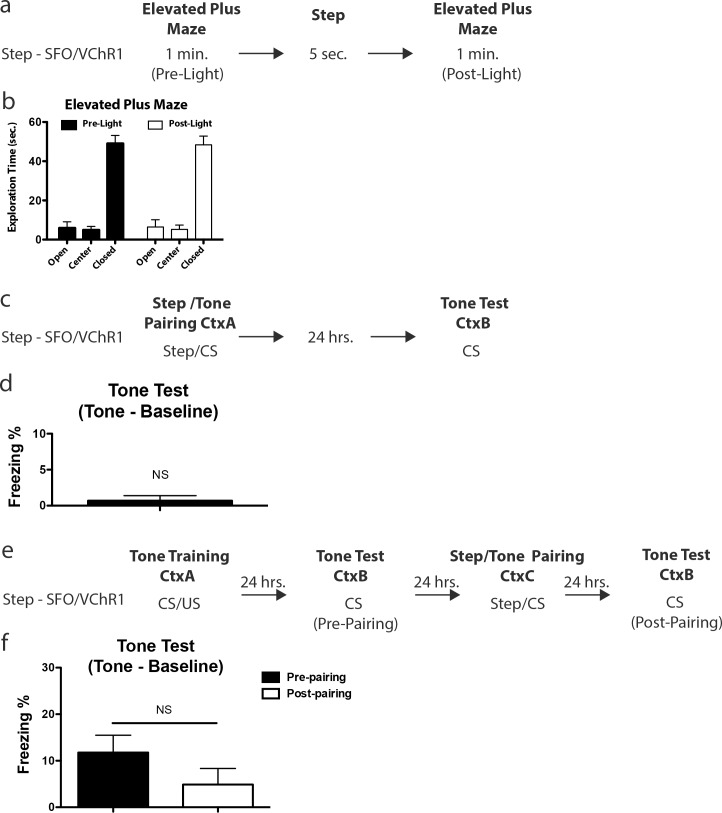
Behavioral controls for excitability induced anxiety and learning.(a) Behavioral design for the elevated plus maze (EPM). (b) The exploration time in the open, center and closed portions of the EPM was monitored for the minute prior to (Pre-Light) and after (Post-Light) a step in excitability. Two-way ANOVA showed a significant effect of arm (F (2,42) = 109.6, p < 0.001) but no significant interaction (F (2,42) = 0.018, p > 0.05) or effect of light (F(1,42) = 3.7x10-7 p > 0.05). The mean exploration times: Pre-Light: Open; 5.96 ± 3.10%, Center; 4.95 ± 1.77%, Closed 49.09 ± 4.06%. Post-Light: Open; 6.43 ± 3.69%, Center; 5.21 ± 2.23%, Closed 48.35 ± 4.46%. (c) Behavioral design for the Step/Tone pairing. (d) Freezing during tone test for the Step—SFO/VChR1 cohort was not above baseline levels (one sample t-test against 0, t(6) = 1, p > 0.05). The mean freezing during tone test: Step—SFO/VChR1; 0.70 ± 0.70%, n = 7. e) Behavioral design for the trained Step/Tone pairing. (f) There was no difference in freezing during the tone test between the Step-SFO/VChR1 and Ctrl-SFO/VChR1 cohorts (unpaired, two-sided t-test, t(27) = 1.35, p > 0.05). The mean freezing levels: Pre-Pairing; 11.76 ±3.72%, n = 15 and Post-Pairing; 4.89 ± 3.46%, n = 14 tone test. Error bars are mean ± SEM. See S4 Fig for baseline freezing levels and analysis.